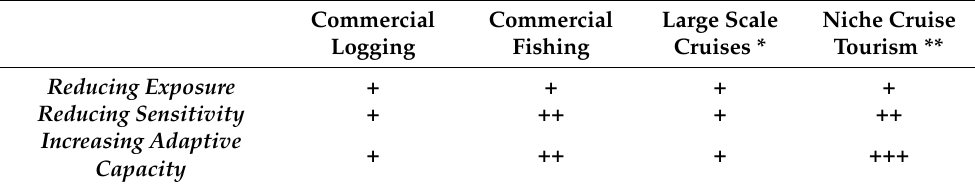
Table 2. Characterization of Emic Views of Contributions to Community Resiliency. Commercial Commercial Large Scale Niche Cruise Logging Fishing Cruises * Tourism ** Reducing Exposure + + + + Reducing Sensitivity + ++ + ++ Increasing Adaptive